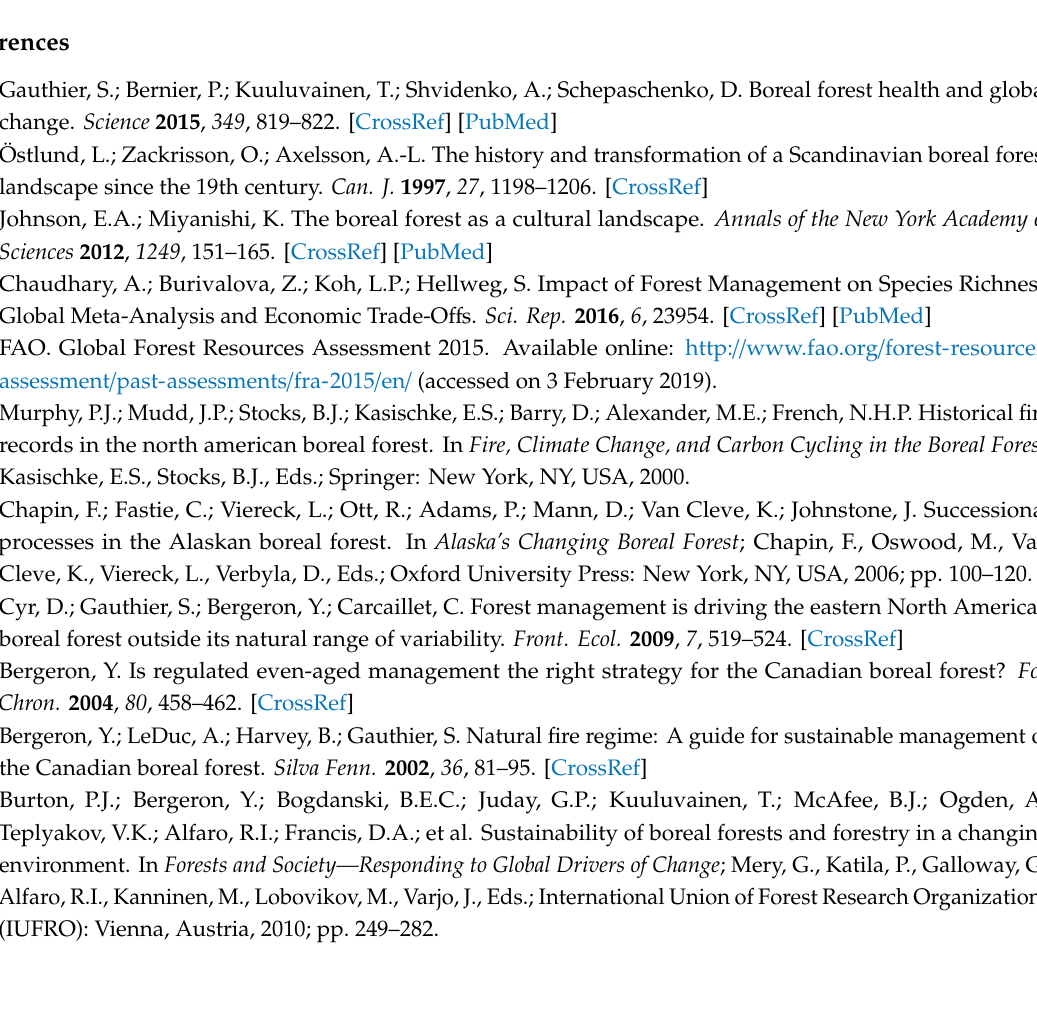
Table S1: Mean DBH (cm) of each specie for each vegetation type (Volume Unit 1 (Fairbanks, Kantishna and Delta management areas)). Table S2: Mean DBH (cm) of each species in each vegetation types (Volume Unit 2 (Tok management